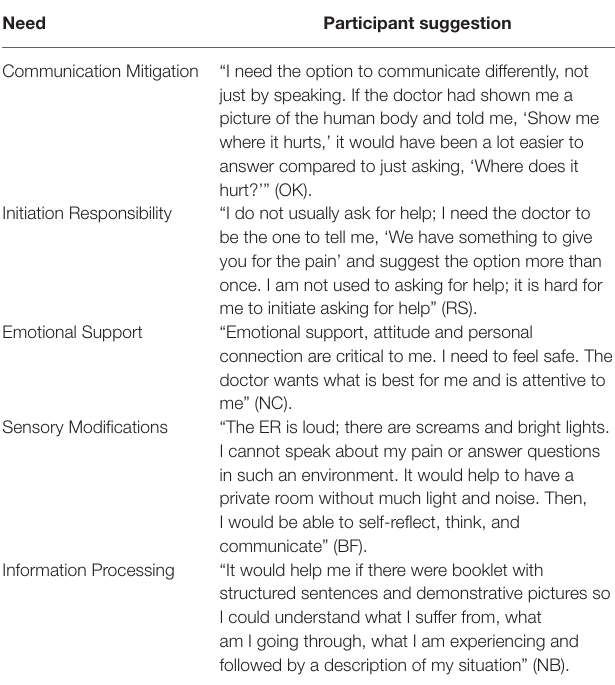
TABLE 2 | Suggestions for healthcare providers.